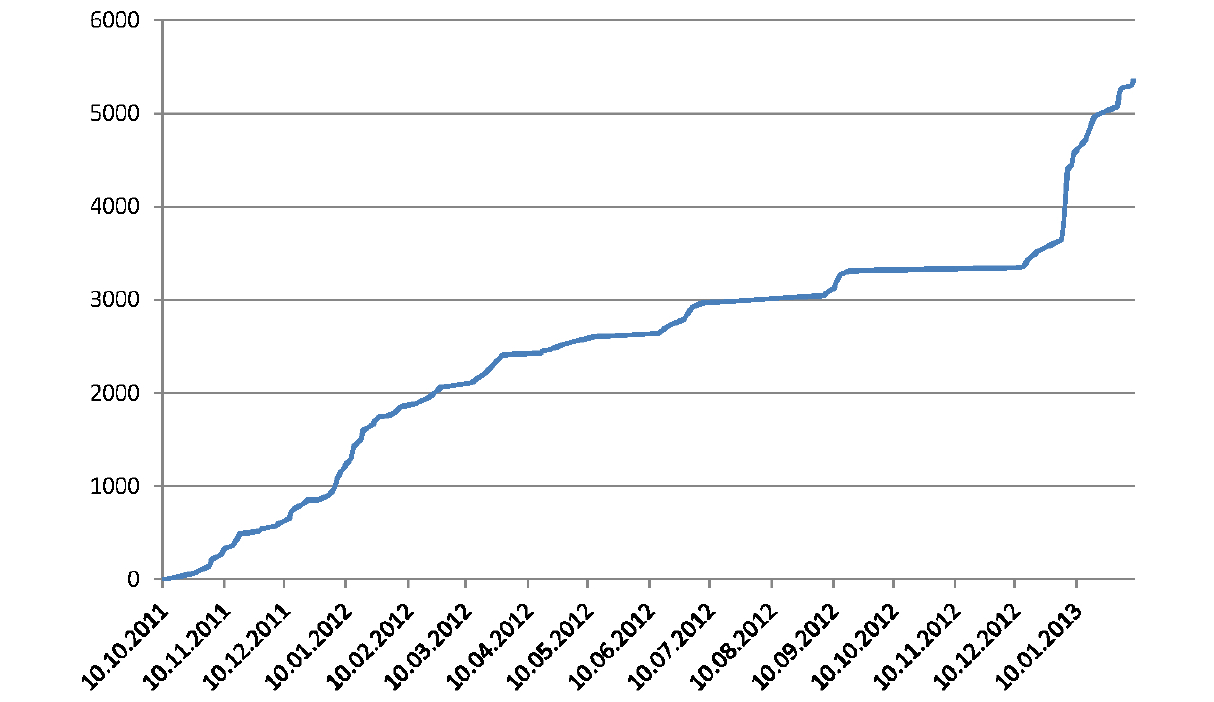
Figure 4. State of ACLO-Web: date vs total number of Learning Objectives